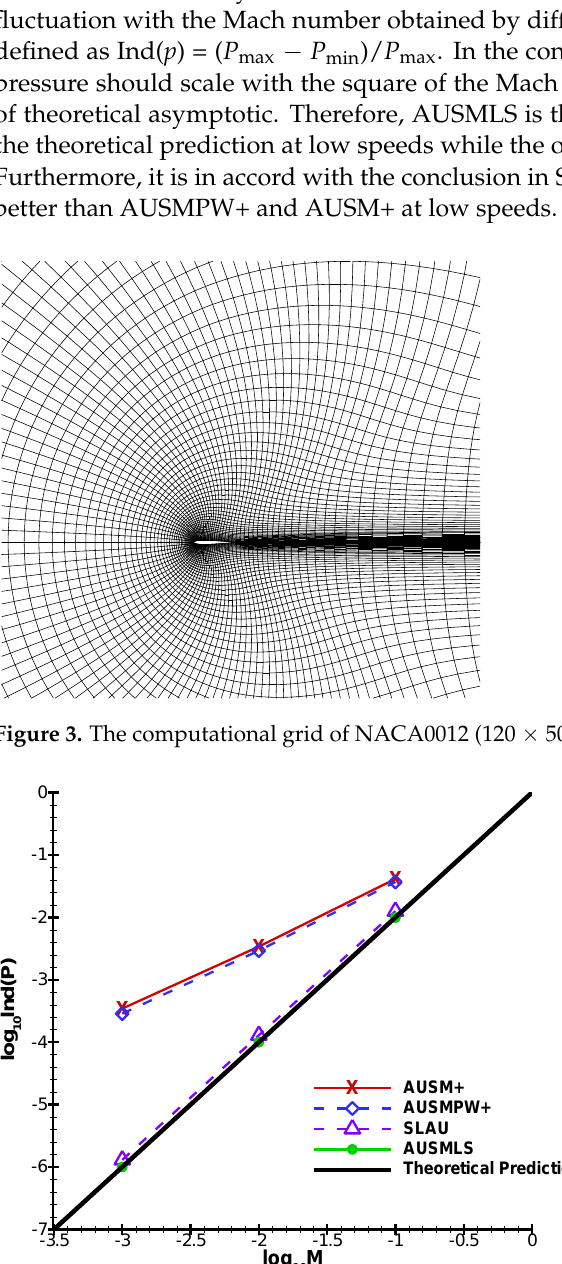
Figure 4. Pressure fluctuations vs. freestream Mach number (first order reconstruction with computa- tional grid of 120 × 50).